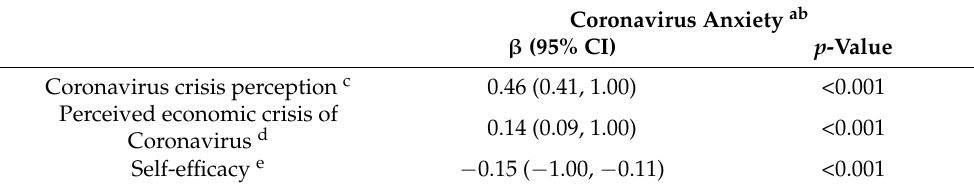
Table 2. Associations Between Cognitive Factors and Coronavirus